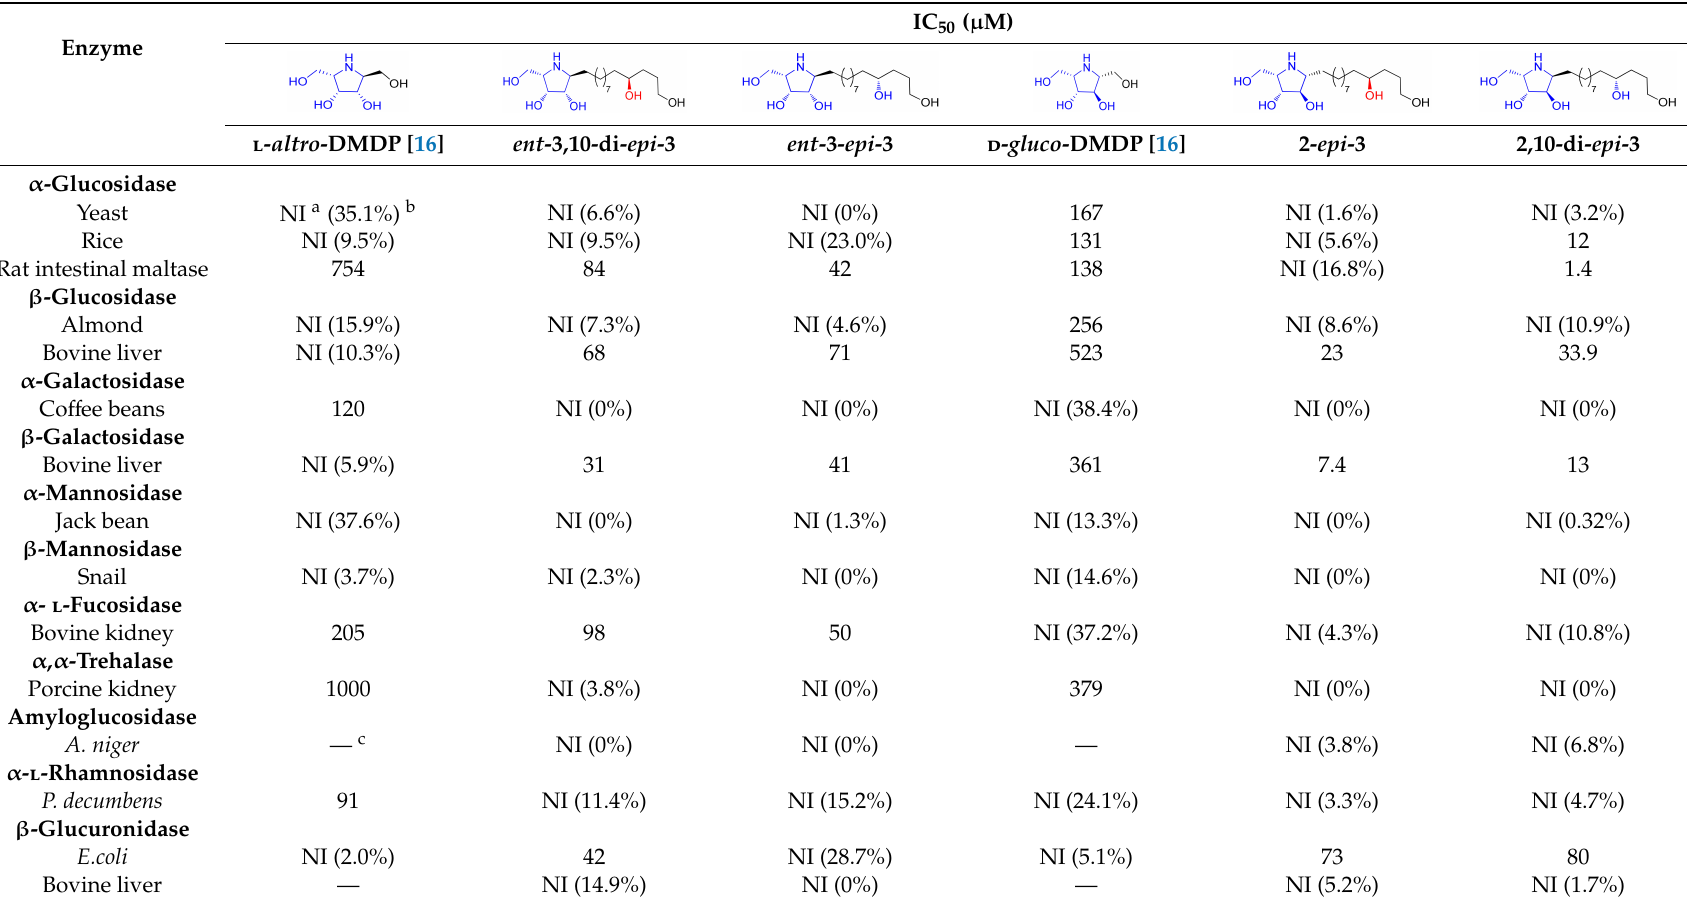
Table 3. Concentrations of Broussonetine M’s analogs related with l - altro -DMDP and d - gluco -DMDP giving 50% inhibition of various